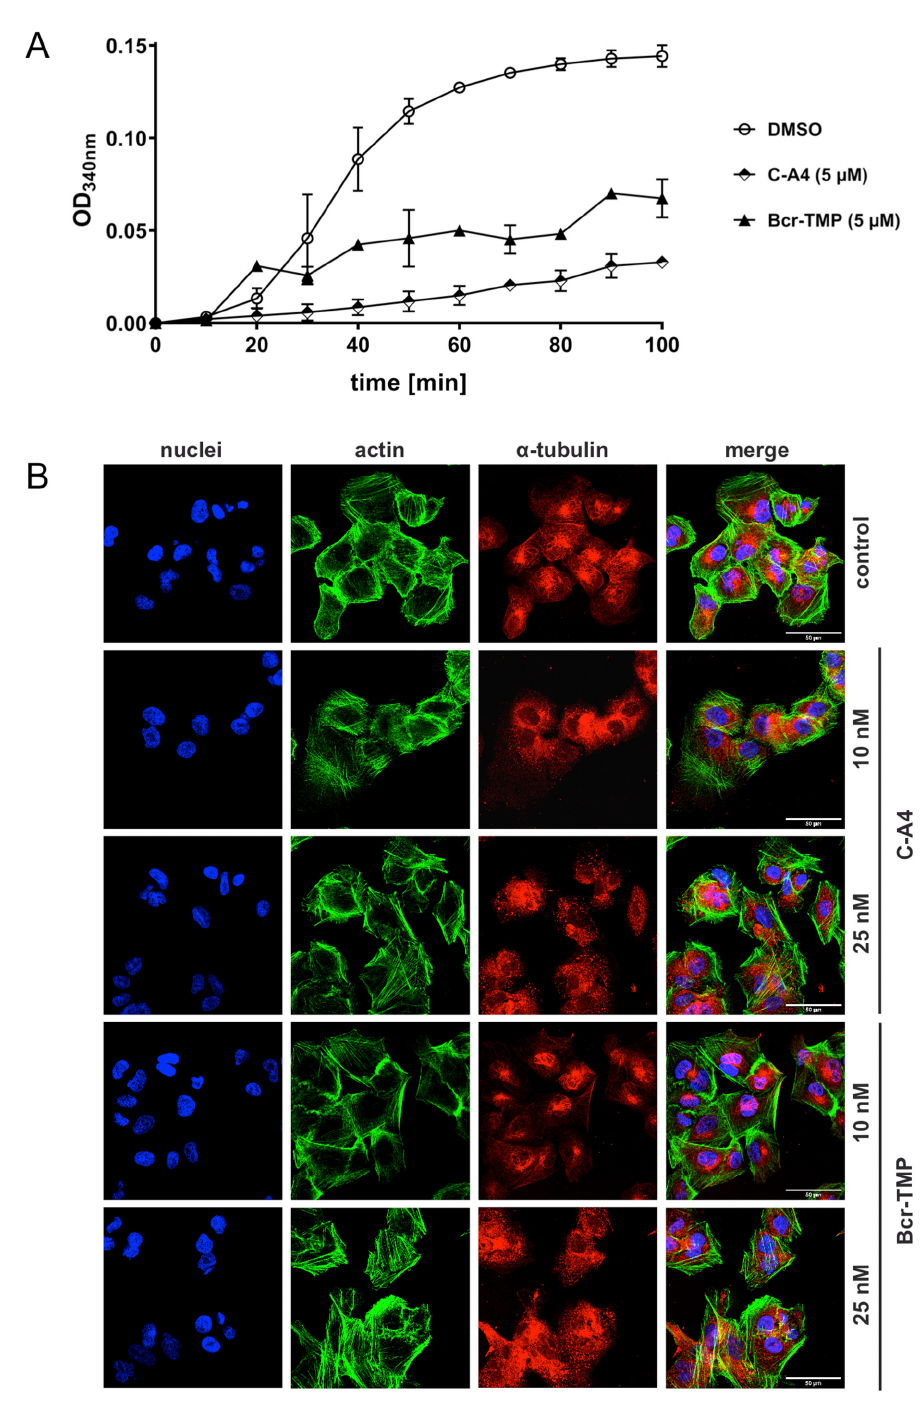
Figure 7. Bcr-TMP inhibits tubulin polymerization and disrupts the microtubule network in 518A2 melanoma cells: ( A ) Effect of Bcr-TMP and combretastatin A4 (5 µ M each) on tubulin polymerization in a turbidimetric in vitro tubulin polymerization assay. DMSO served as negative control. ( B ) Con- centration dependent effect of 10 and 25 nM combretastatin A4 or Bcr-TMP on the tubulin and actin cytoskeleton of 518A2 melanoma cells after 24 h of treatment. DMSO treated cells served as negative control. Individual panels show nuclei (blue), actin (green), and tubulin (red) as well as a merge of all three. Images are representative of at least three independent experiments. The scale bar (bottom right in the leftmost panels) corresponds to 50 µ